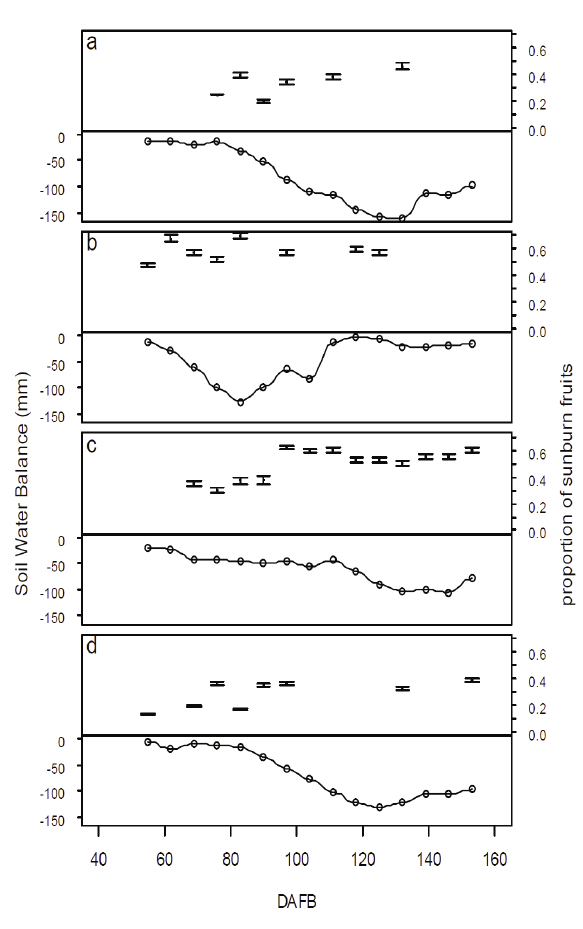
Fig. 2 ­ Proportion of sunburn fruits and soil water balance (SWB) by number of days after full bloom (DAFB) for four production cycles. a, cycle 1; b, cycle 2; c, cycle 3; d, cycle 4. The error bars represent standard deviation.